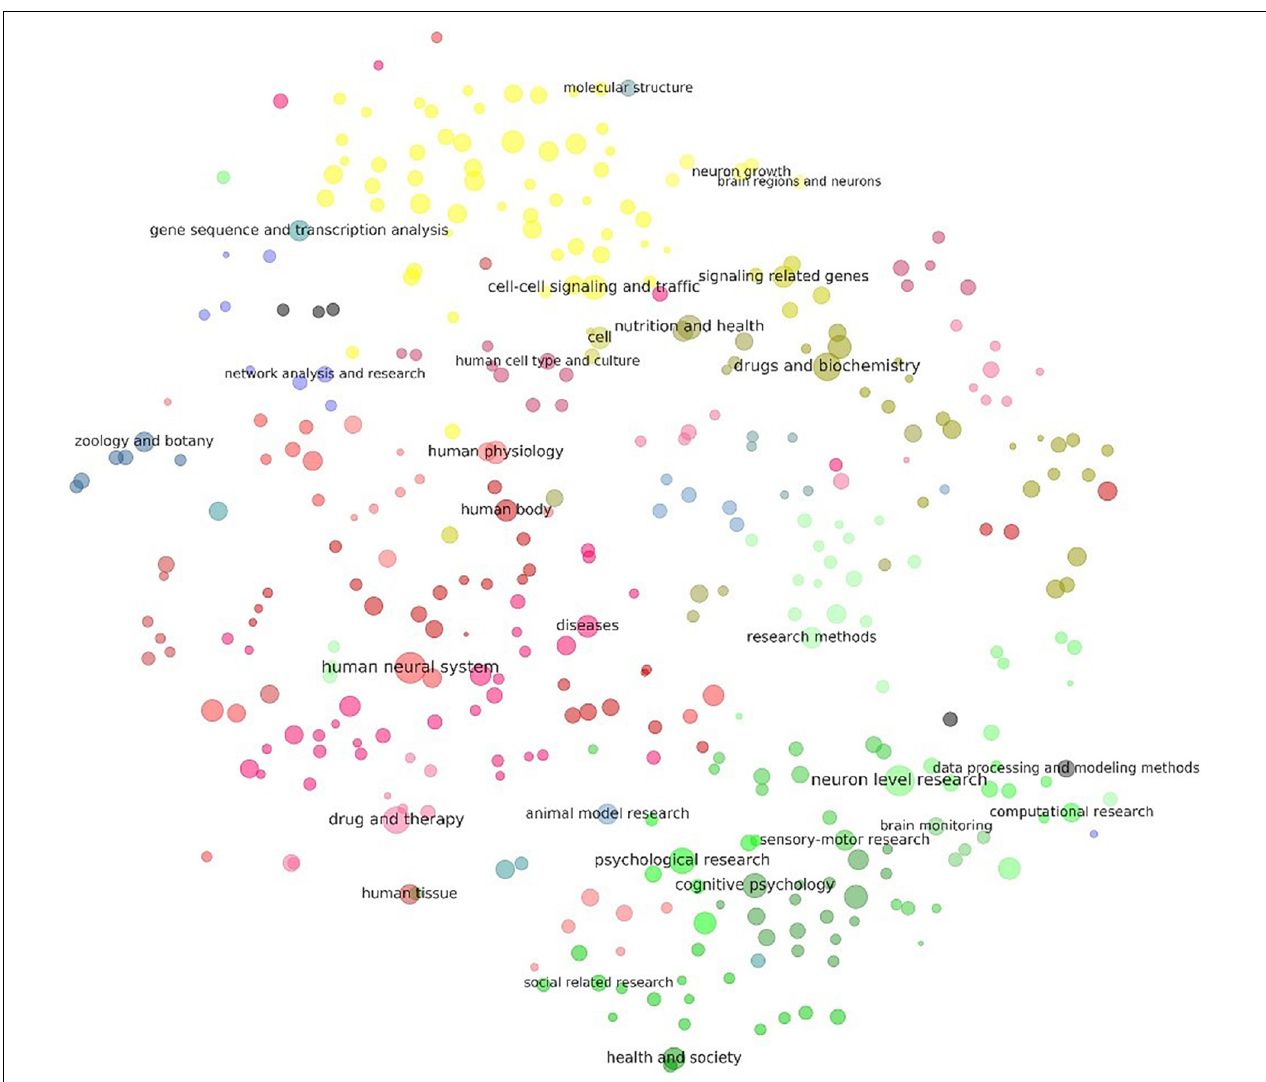
FIGURE 4 | Visualization of the results of clustering of keywords related to neuroscience research. Each dot in the above figure represents a keyword cluster. The size of the dot represents the total number of references to the corresponding keywords in the cluster. The color of the dot represents level 3 of the cluster. The name of the cluster is provided on the largest dot under the level-3 cluster. Dot coordination was determined by the average word vector of terms in the cluster as calculated by the TSNE algorithm. More detailed results of the visualization of the same layout are given in Supplementary Material S7 , where all cluster names are tagged.